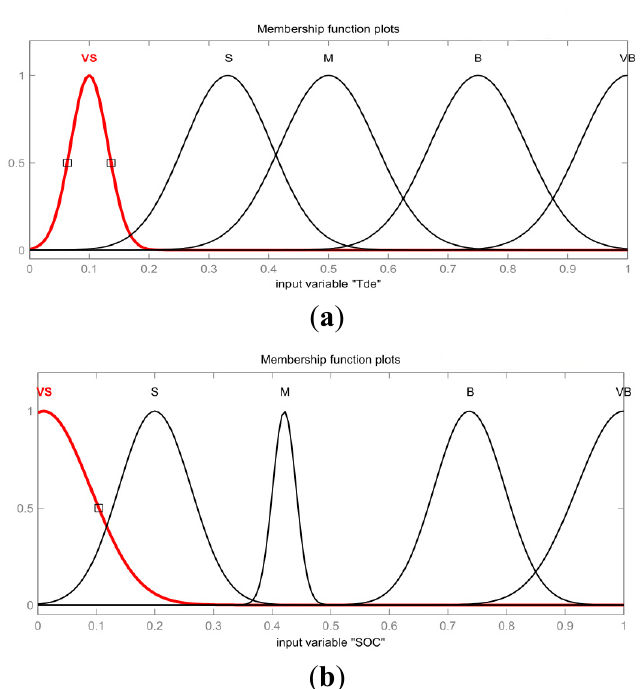
Figure 13. ( a ) Final membership functions of T dem under New European Driving Cycle (NEDC); ( b ) Initial membership functions of SOC under NEDC.